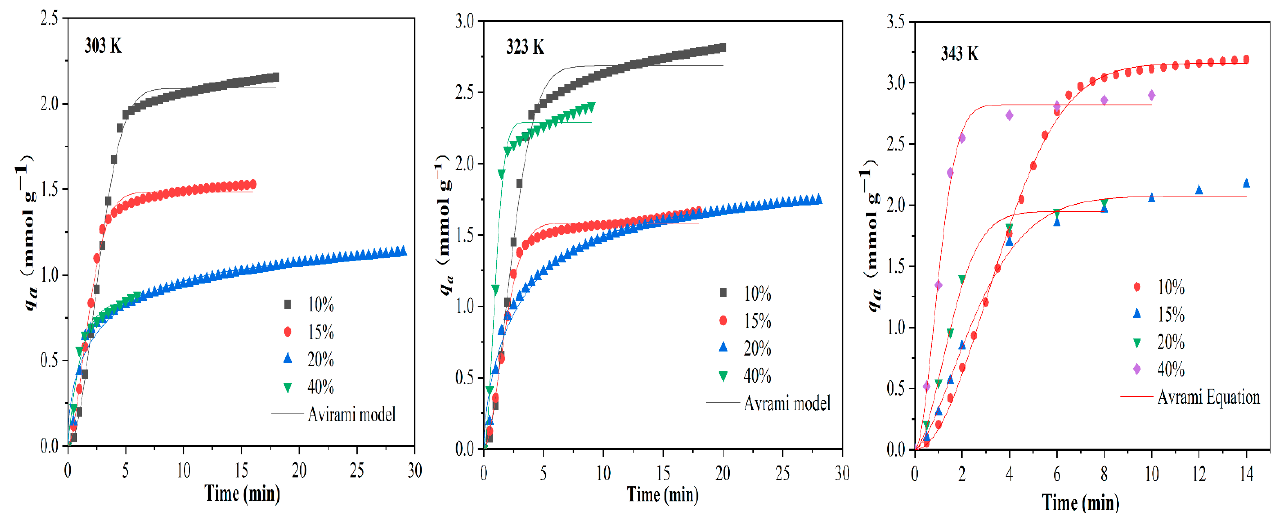
Figure 7. The results of the Avrami kinetics models and the experimental CO 2 uptakes of AMMS-T. Table 5. The approximate values of the model parameters obtained by Avrami’s model and the corresponding correlation coefficient R 2